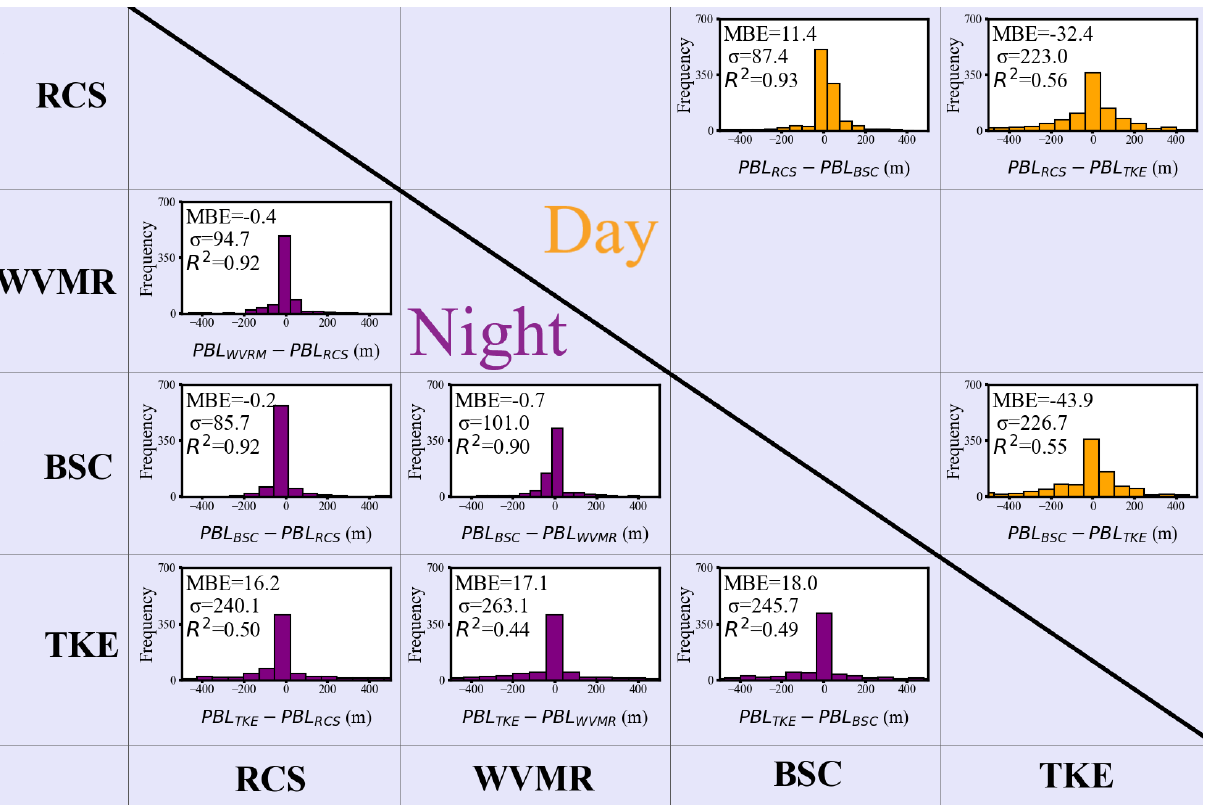
Figure 16. Statistical analysis of the differences between products and methods for 1 – 26 April 2017, separated into day and night periods.